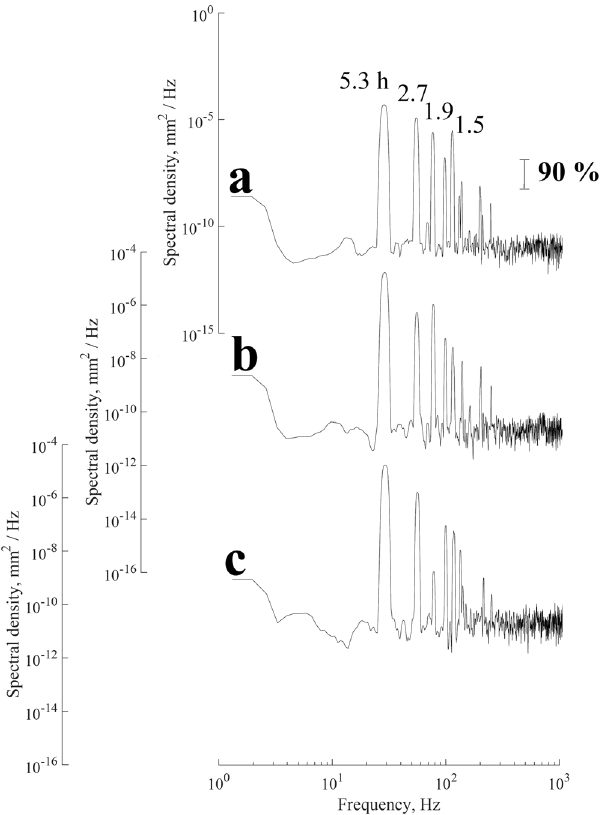
Figure 5. Frequency spectra of the modelled water level fluctuations in the lake at sites in the ( a ) northeast, ( b ) east, and ( c ) west. Arabic numerals show the periods of the main peaks in the spectrum. The vertical line shows the 90% confidence interval with 10 degrees of